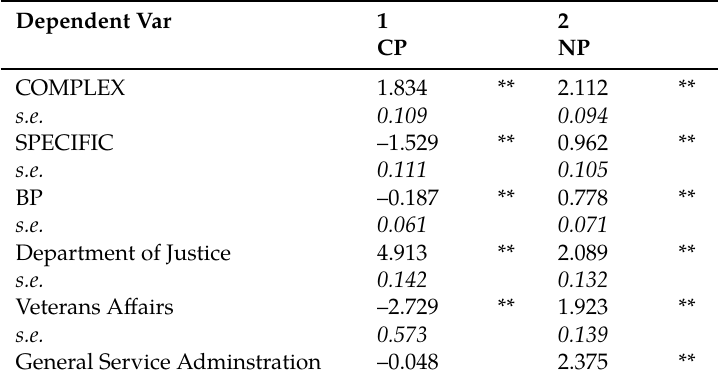
Table 6: Logit regression